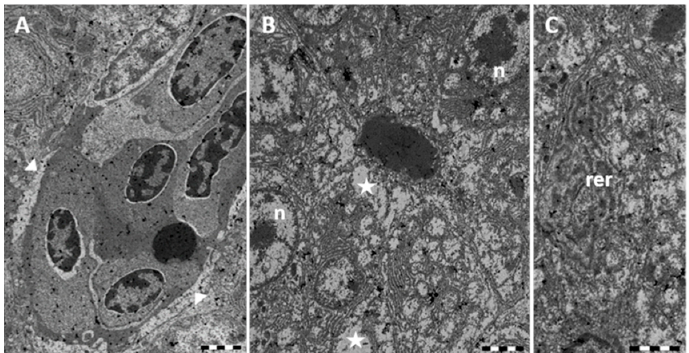
Figure 4. TEM micrographs of Danio rerio liver section after 96 h of exposure to 7.7 μ g/L HgCl 2 . ( A ) Alterations in the Disse’s space (arrowheads); ( B ) In the hepatocyte large cytoplasmic lacunae (star) are detected; nuclei (n) appear damaged; ( C ) The rough endoplasmic reticulum (rer) is considerably dilated and fragmented. Bar 2 μ m.